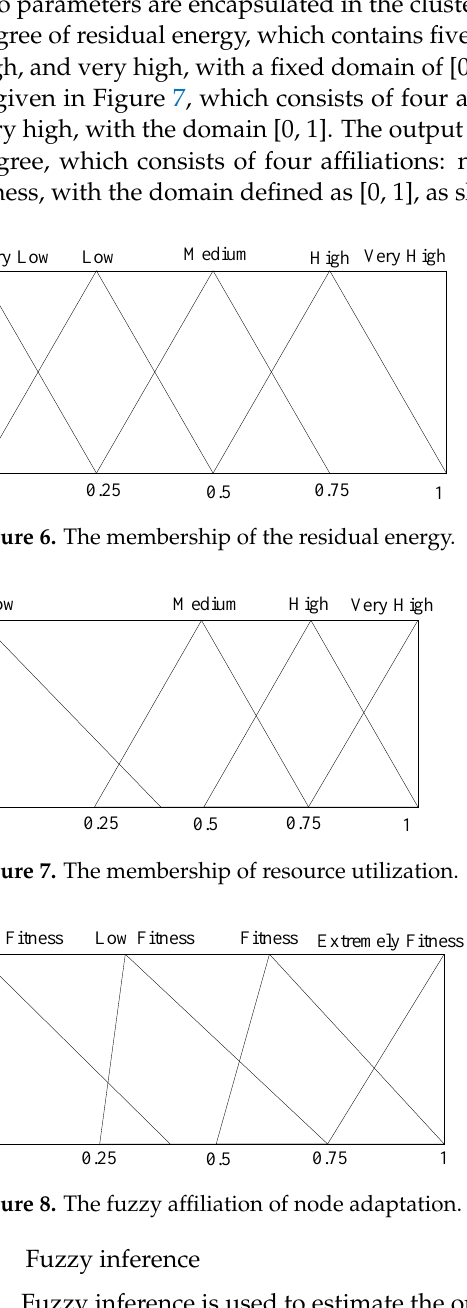
Figure 5. The attribution function.